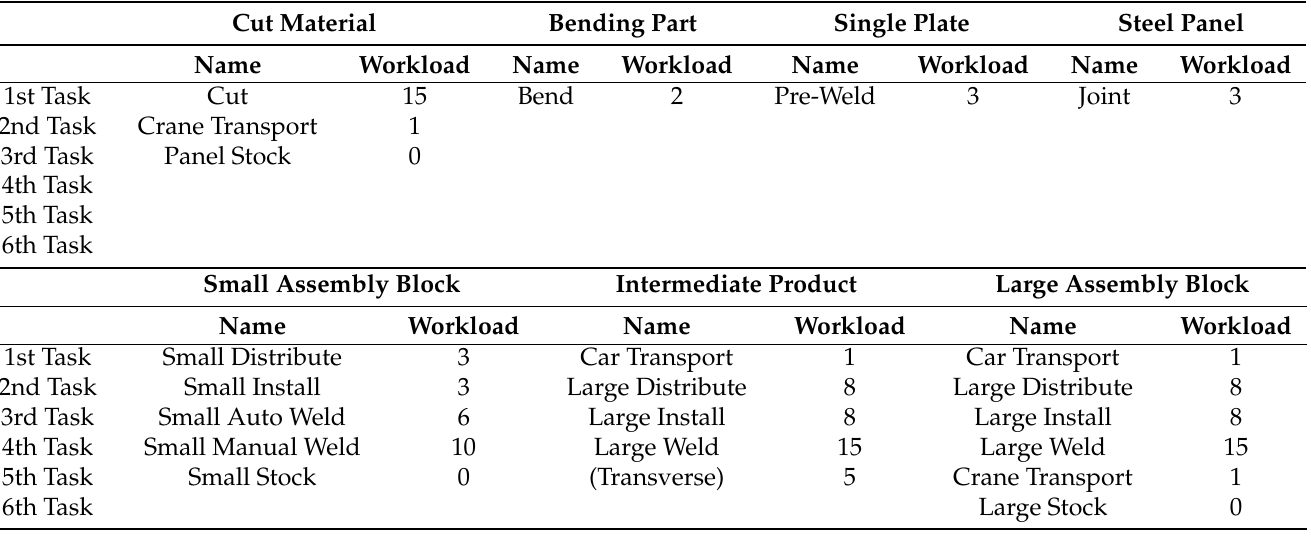
Table 1. BOP Data in Case Study.